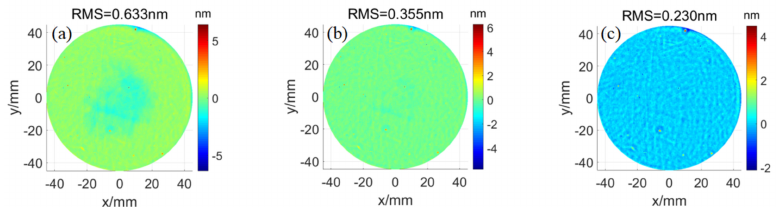
Figure 19. Simulated figuring results of ( a ) the first iteration, ( b ) the second iteration, and ( c ) the third iteration.